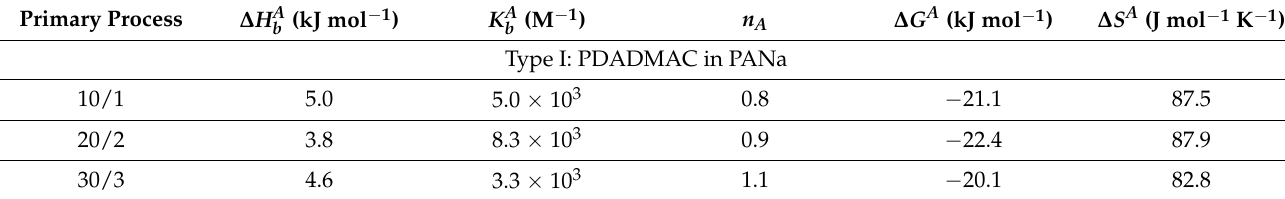
Table 3. Thermodynamic parameters for primary and secondary processes obtained from the adjust- ment of the ITC curves with MNIS model fitting. ∆ H A enthalpy, binding constant, stoichiometry, free energy, and entropy changes, respectively. Reproduced with permission from Soft Matter, 2014, 10, 9496. Copyright 2018 Royal Society of